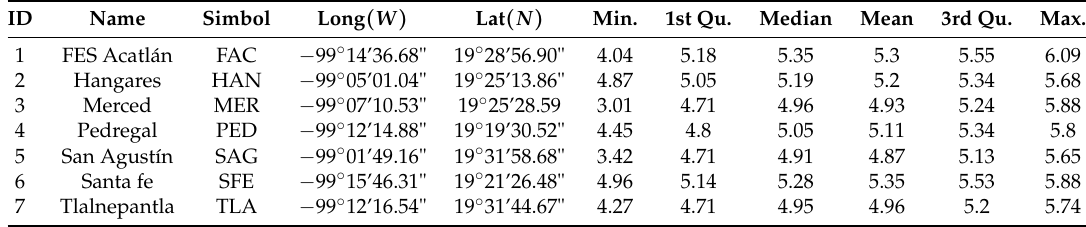
Table 1. Descriptive summary information on the UVB radiation maxima on the Mexico City metropolitan